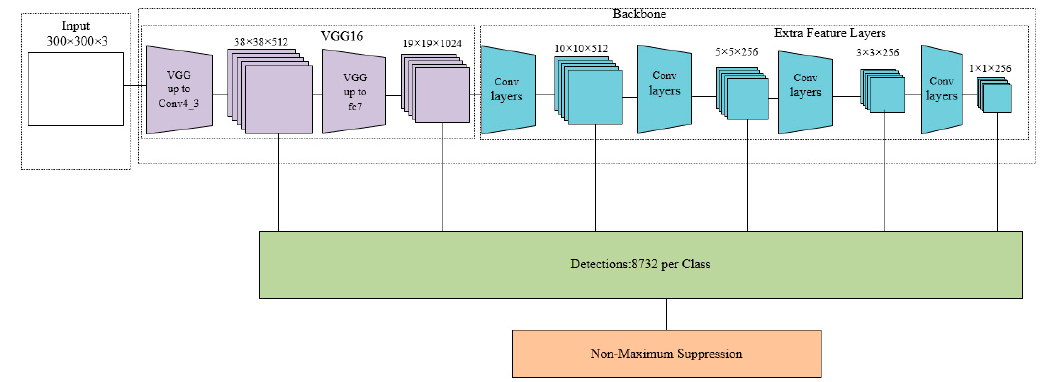
Figure 2. Single shot multibox detector (SSD) network.